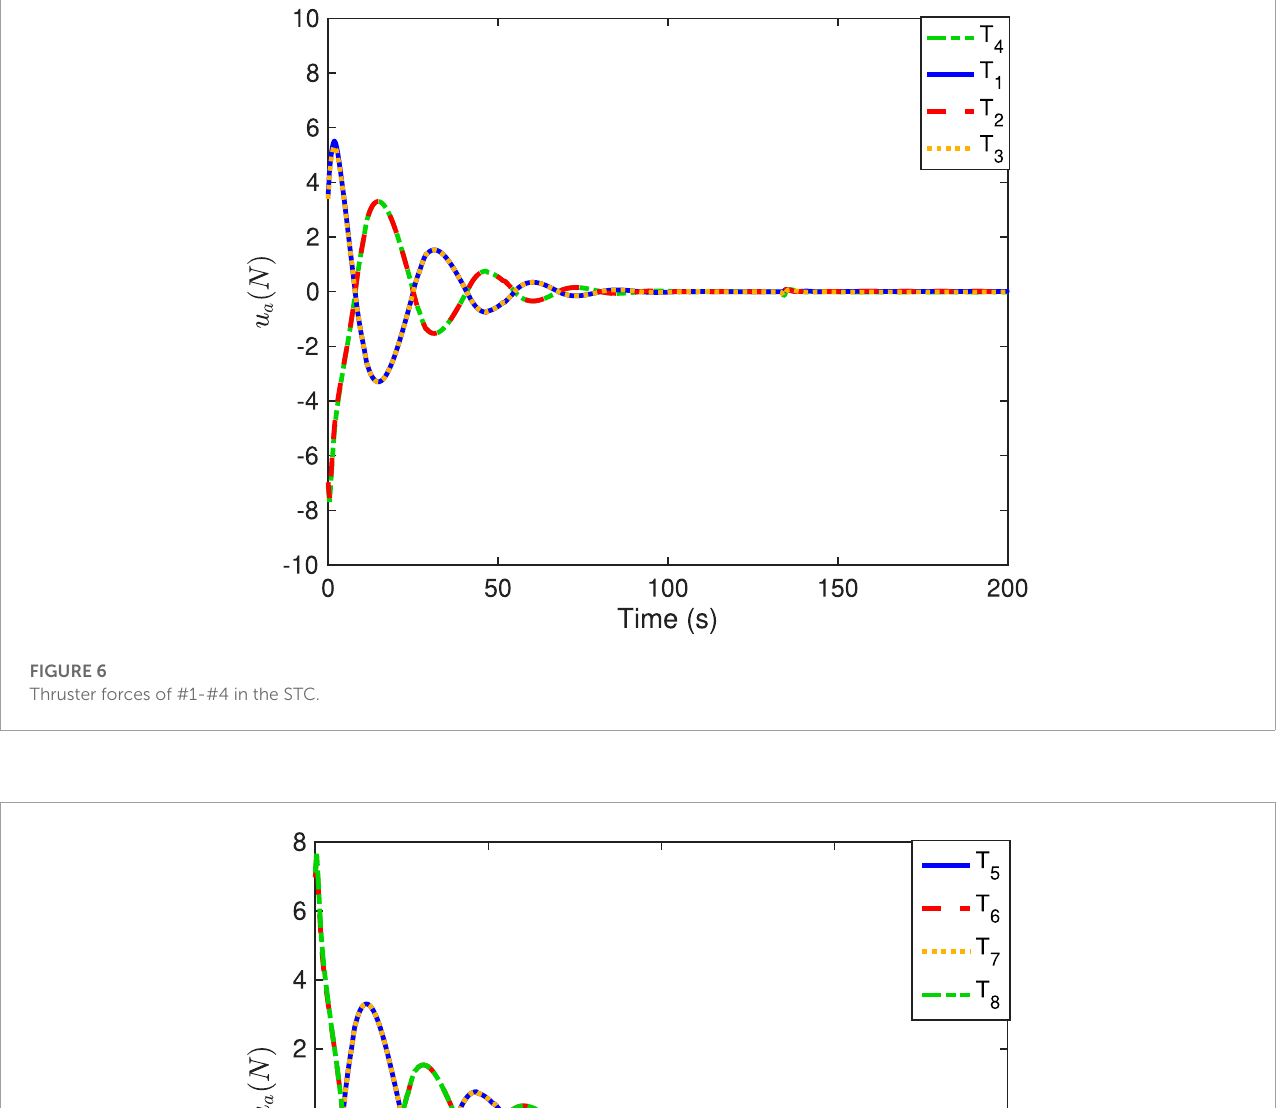
FIGURE 7 Thruster forces of #5-#8 in the STC.